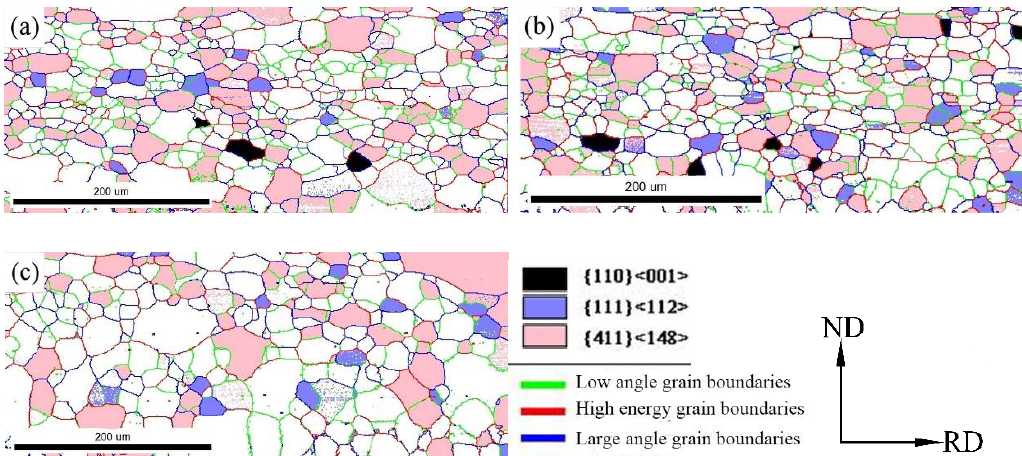
Figure 4. Grain boundaries of decarbonized annealing samples along the thickness direction: ( a ) 850 ◦ C × 3 min; ( b ) 850 ◦ C × 5 min; ( c ) 850 ◦ C × 7 min (green is a low-angle grain boundary (orientation difference <15 ◦ ), red is a high-energy grain boundary of high mobility (orientation difference of 20 ◦ to 45 ◦ ) and blue is a large-angle grain boundary (orientation difference >45 ◦ ). Black represents Goss texture, purple represents {111} <112> texture and pink represents {411} <148> texture.